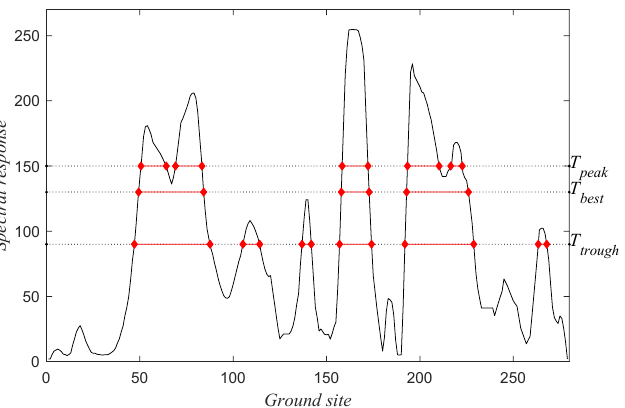
Figure 9. One-dimension simulated spectral response for thresholding under different